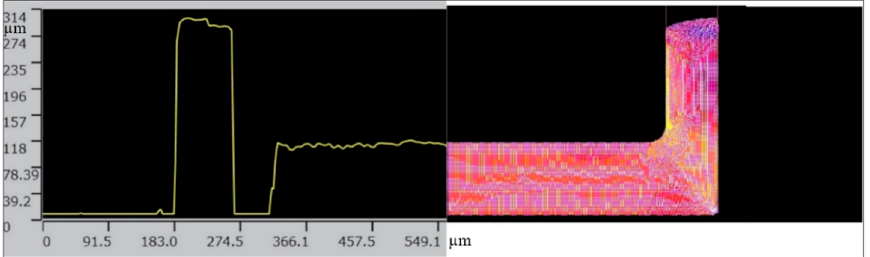
Figure 6. Comparison of the geometry of the backward extrusion workpiece obtained from the experiment and the simulation.